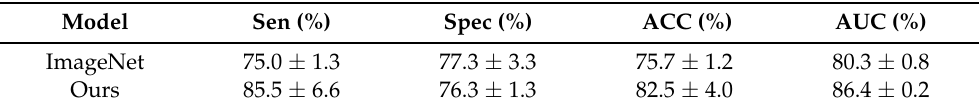
Table 6. Comparison of the SE-ResNet50 model performance based on different pre-training methods in the validation cohort.